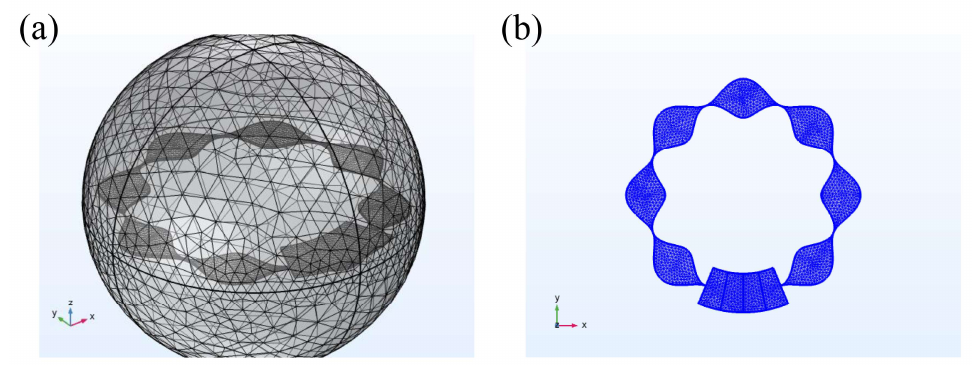
Figure 4. ( a ) Overall model with mesh generation and ( b ) middle section of Figure 4a with one cycle of fan-shaped electrodes.